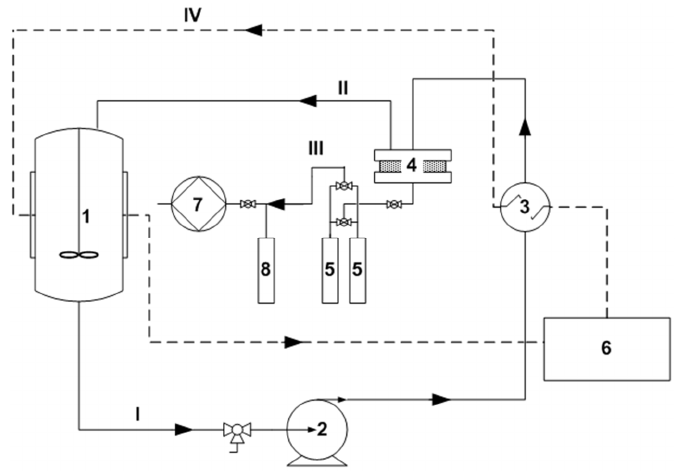
Figure 1. Scheme of the vacuum pervaporation setup: 1—a container with a mixing device; 2—a gear pump; 3—a heat exchanger; 4—a membrane module; 5—traps for collecting permeate, placed in Dewar vessels with liquid nitrogen; 6—thermostat; 7—vacuum pump; 8—safety trap; I—initial separable mixture; II—retentate; III—permeate; IV—coolant.